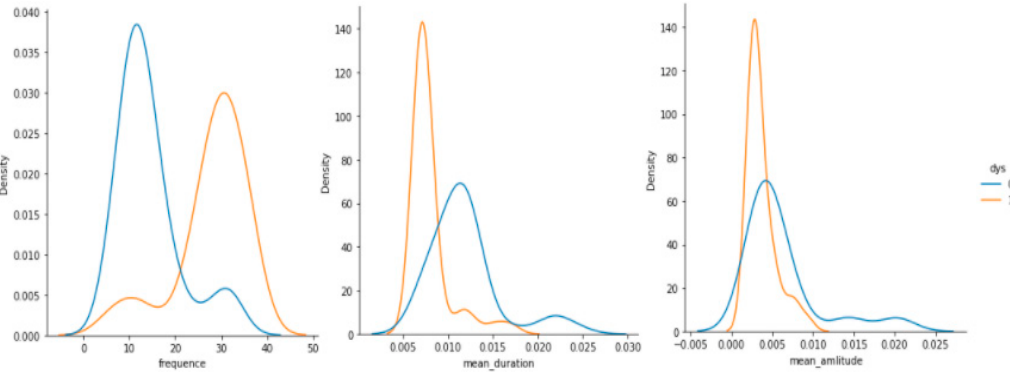
Figure A7. Distribution of the DGI for the painting 3 dataset.